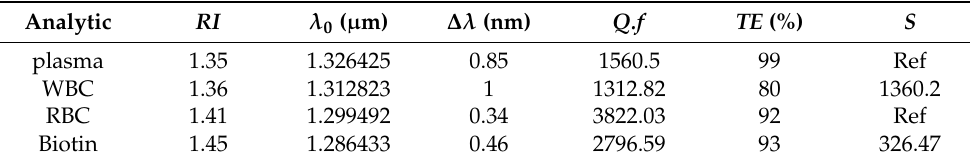
Table 1. Major parameters of the biosensor computed for different elements of blood. Analytic